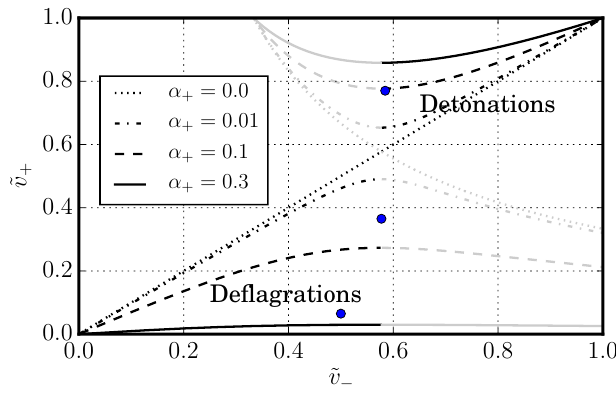
Figure 13: The fluid velocity just ahead the wall ˜ v + as a function of the fluid velocity just behind the wall ˜ v − in the rest frame of the wall for different transitions strength parameters α + . For physical solutions to exist, both velocities have to be subsonic (deflagrations) or supersonic (detonations) as indicated by the black lines. Non- physical solutions are indicated by the gray lines. The fluid velocity has an extremum (cid:112) = 1 / at ˜ v + = c with the speed of sound set to c 3 in this plot. The velocity profiles s s at the blue dots are presented in Fig. 15. Figure taken from Ref. [ 66